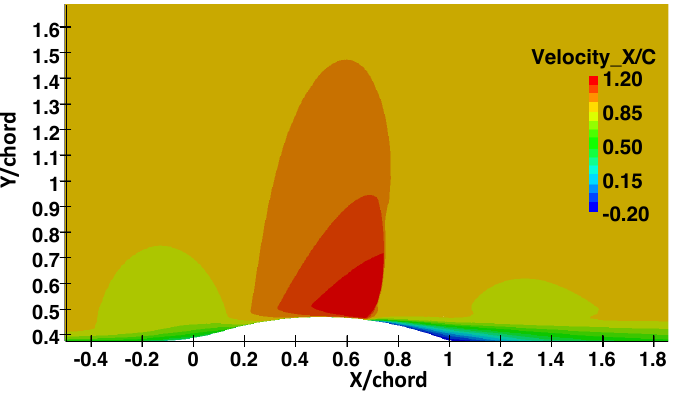
Figure 7. WA-URANS of Bachalo-Johnson flow: contours of mean streamwise velocity normalized by free-stream speed of